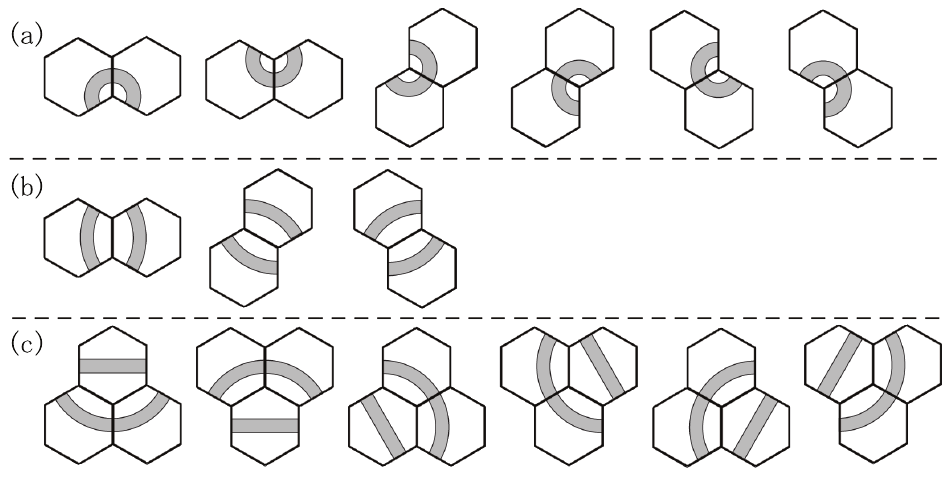
Figure 13. Forbidden arrangements of lines of the designated color for challenge